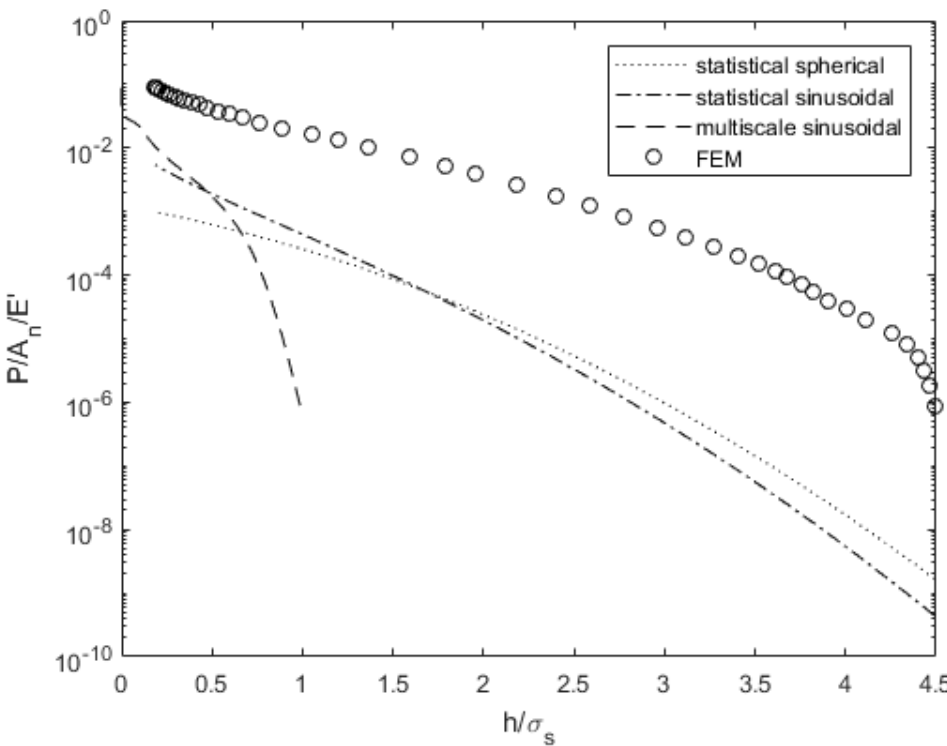
Figure 9. Load comparison for varying surface separation for surface 63M.